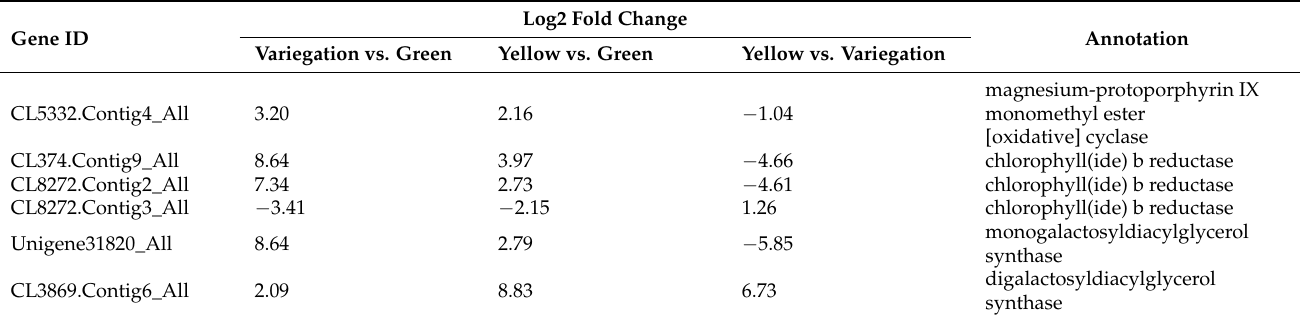
Table 3. Putative structure genes involved in chlorophyll metabolism and chloroplast integrity and function. Log2 Fold Change Gene ID